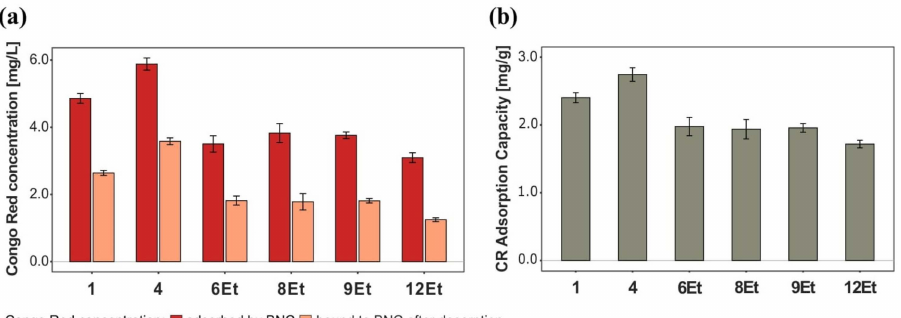
Figure 5. The results of Congo Red loading (adsorption-desorption) studies. ( a ) Comparison of the dye concentration adsorbed by BNC membranes to its quantity remaining in the material after rinsing process, ( b ) Congo Red adsorption capacity